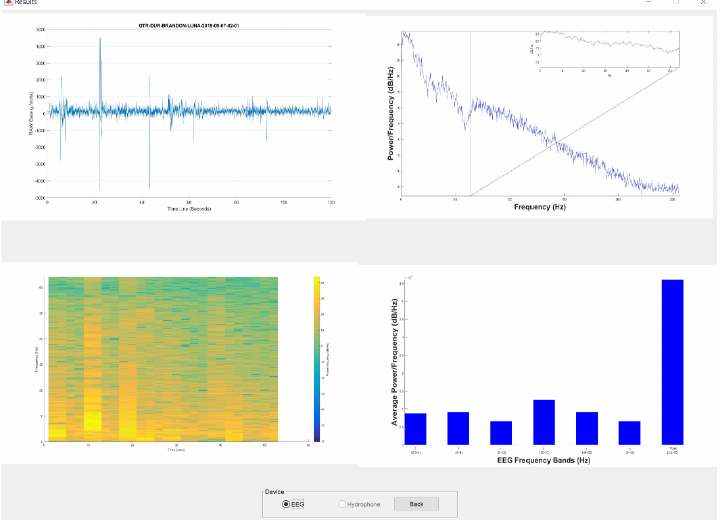
Figure 13. Results of the EEG